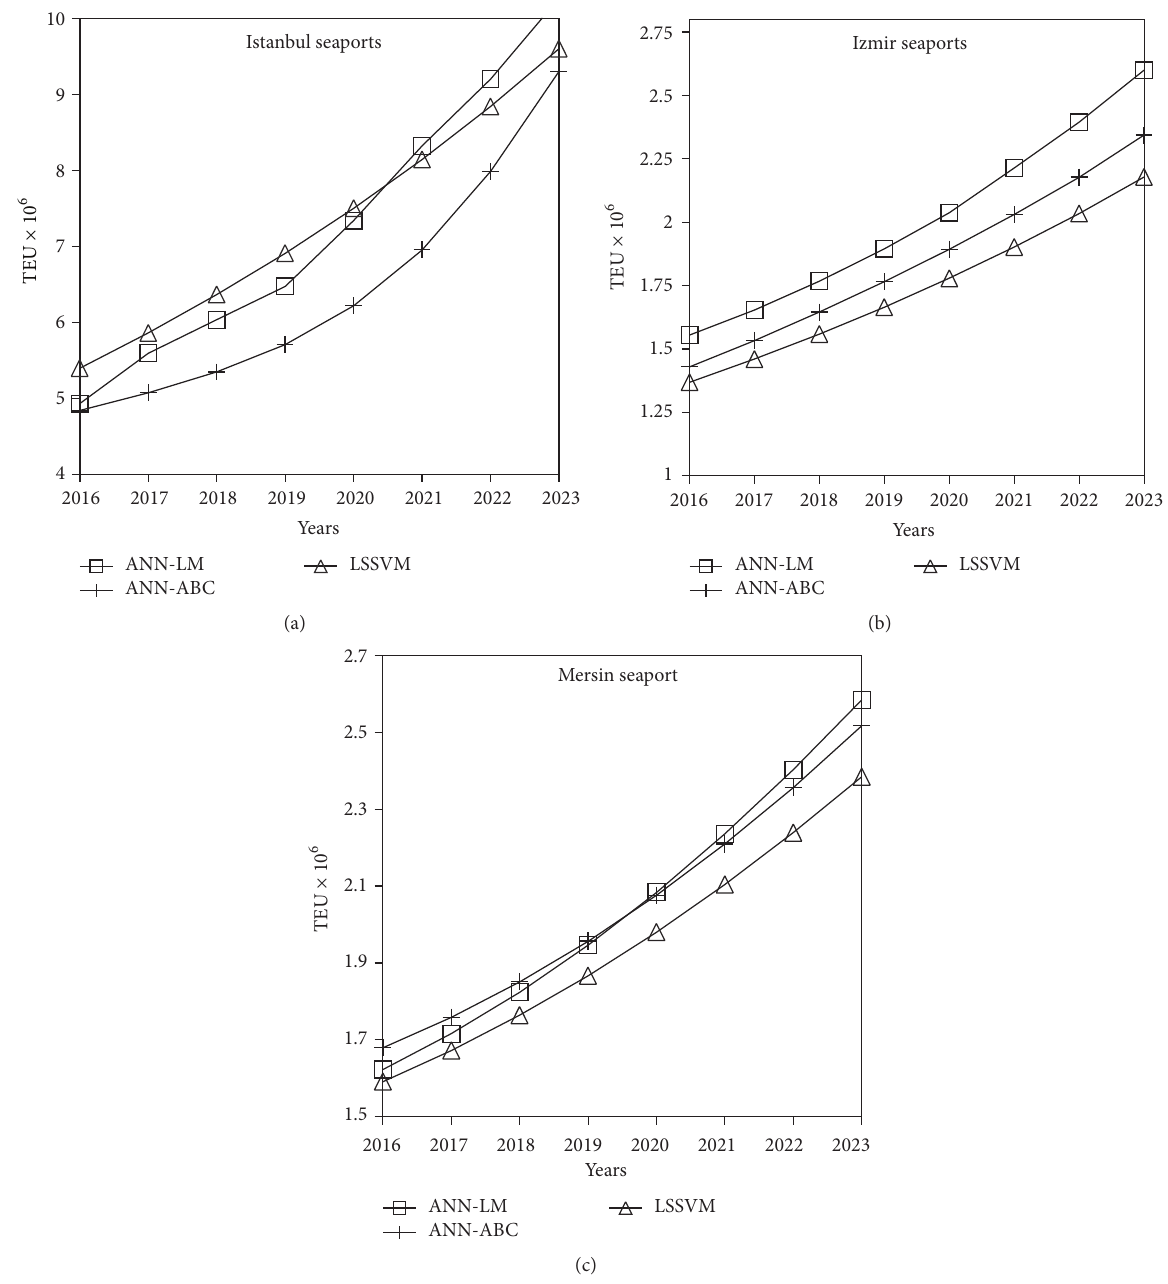
Figure 6: Model results for forecast period: